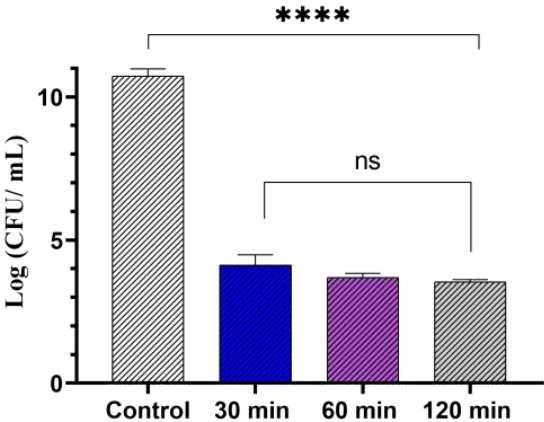
Figure 6. The viability of P. aeruginosa planktonic culture following treatment with GaPP-LCNP (0.8 µ M), light dose of 17.2 J.cm − 2 , compared to negative control after 2 h in the dark. Data presented as mean ± SD, n = 3. ns: non-significant reduction, **** significant reduction p value < 0.0001 (one-way ANOVA test followed by Tukey’s multiple comparison test) .